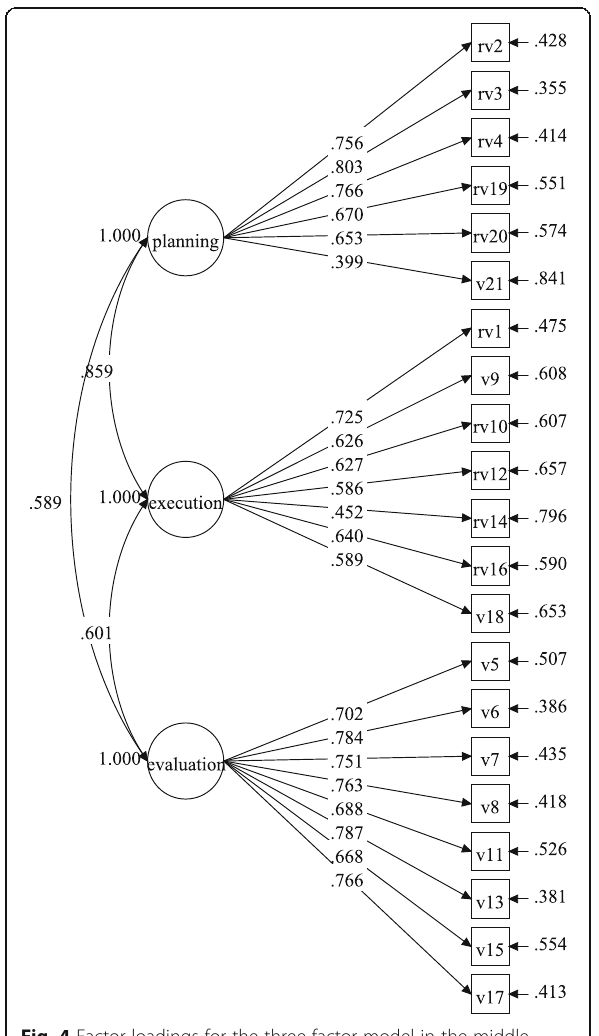
Fig. 4 Factor loadings for the three-factor model in the middle school